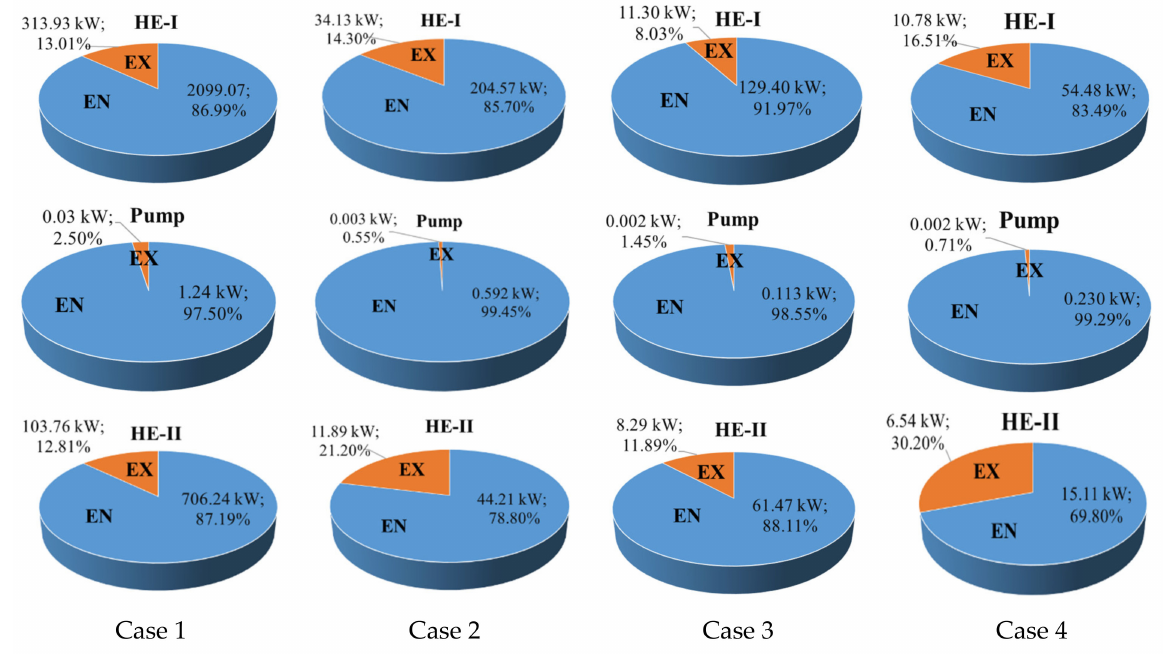
Figure 6. Advanced exergy assessment results with respect to endogenous and exogenous